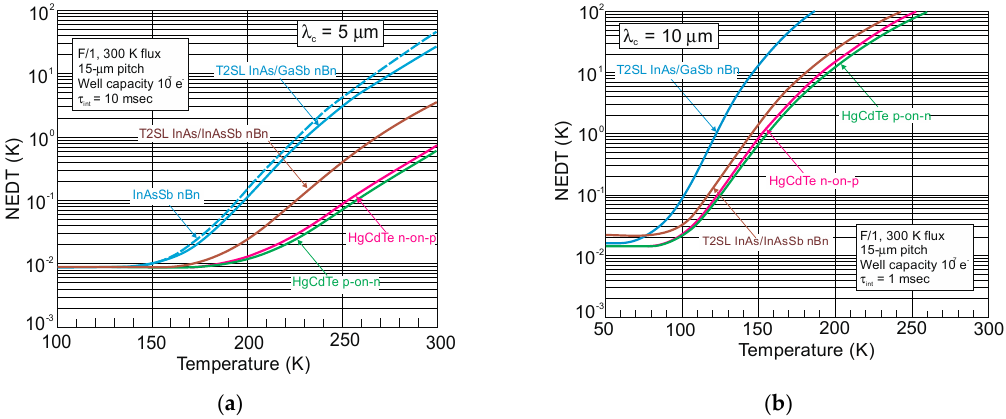
Figure 71. NEDT versus temperature for barrier detectors and HgCdTe photodiodes for λ cut-off = 5 μ m ( a ) and 10 μ m ( b ).